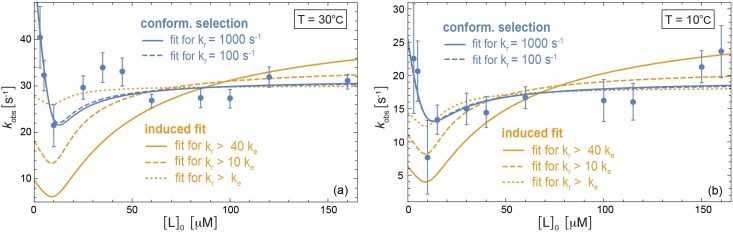
Analysis of experimentally determined relaxation rates kobs for the binding of recoverin to a rhodopsin kinase peptide ligand.The data points represent results of Chakrabarti et al. [28] obtained from chemical relaxation experiments at the temperatures 30°C and 10°C for a recoverin concentration of 10 μM. The blue lines result from fits of Eq (6) for conformational-selection binding with the values kr = 1000 s−1 (full) and kr = 100 s−1 (dashed) of the conformational relaxation rate. At 30°C, the parameter values obtained from fitting are ke = 31.5 ± 0.8 s−1 and k− = 5.1 ± 0.4 s−1 for kr = 1000 s−1, and ke = 31.1 ± 0.8 s−1 and k− = 5.0 ± 0.4 s−1 for kr = 100 s−1. At 10°C, the fit parameter values are ke = 19.3 ± 1.4 s−1 and k− = 3.9 ± 0.7 s−1 for kr = 1000 s−1, and ke = 19.0 ± 1.3 s−1 and k− = 3.8 ± 0.7 s−1 for kr = 100s−1. The yellow lines represent fits of Eq (1) for induced-fit binding with constraints on the conformational excitation and relaxation rates ke and kr. At 30°C, the obtained fit values for the conformational exchange rates are ke = kr = 15 ± 10 s−1 for the constraint kr > ke, ke = 3.1 ± 1.9 s−1 and kr = 31 ± 4s−1 for the constraint kr > 10ke, and ke = 1.1 ± 0.8 s−1 and kr = 44 ± 8 s−1 for kr > 40ke. At 10°C, the fit values are ke = 4.5 ± 4.0 s−1 and kr = 14 ± 10 s−1 for the constraint kr > ke, ke = 1.9 ± 1.5 s−1 and kr = 19 ± 5 s−1 for kr > 10ke, and ke = 0.7 ± 0.5 s−1 and kr = 28 ± 11 s−1 for kr > 40ke. In all fits of Eq (1) for induced-fit binding, we obtain k− ≫ kr, i.e. the fit values of the unbinding rate k− are much larger than the conformational relaxation rate kr and cannot be specified.